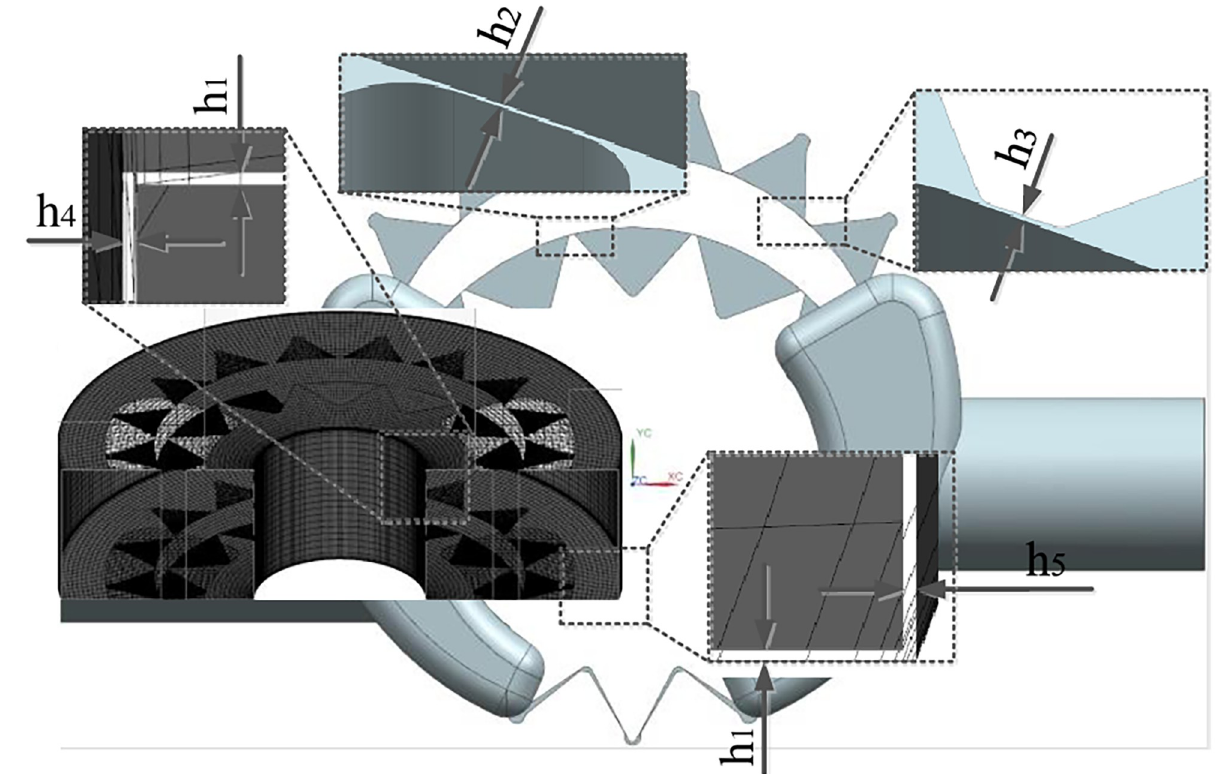
Fig 8. Three-dimensional fluid model considering the oil film thickness.